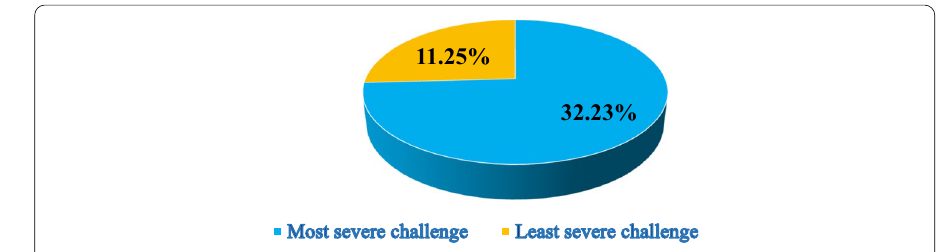
Fig. 18 Severity correlation of the third highest ranking challenge